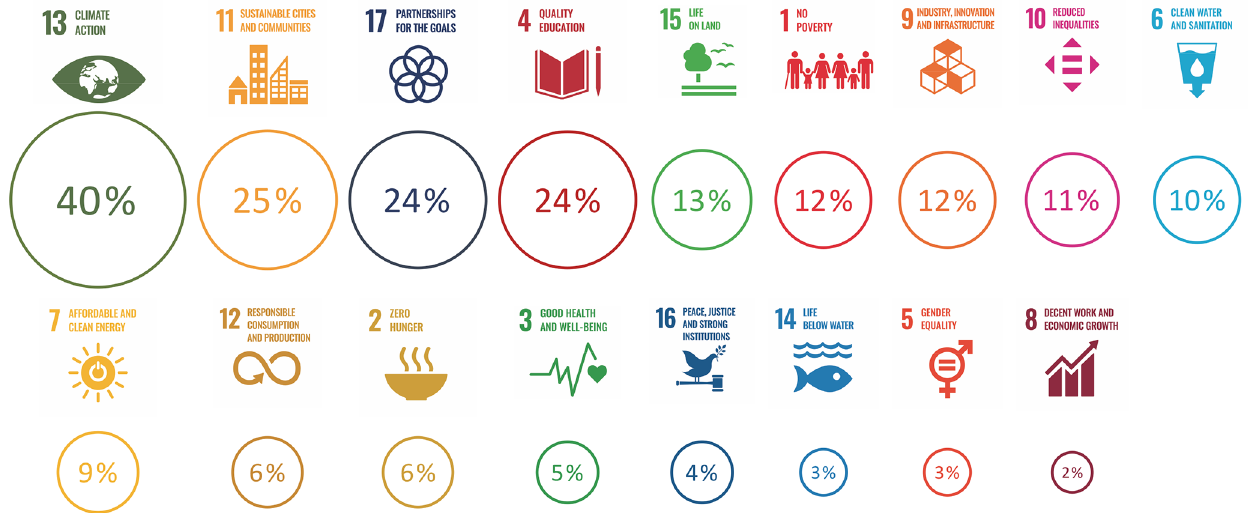
Figure 3. Percentage of n = 188 natural hazard community members referring to specific United Nations Sustainable Development Goals (SDGs) in response to NHESS survey question Q2 on broad step changes that the natural hazards community could make to achieve the SDGs. The percentages have been determined out of the total number of respondents that specified an SDG ( n = 188), not all respondents ( n = 350). SDG icons from United Nations